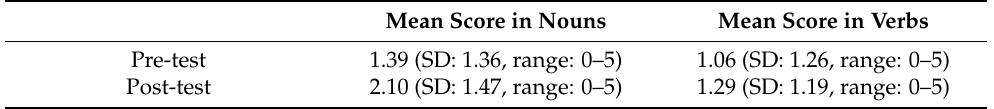
Figure 1. Boxplot graph representing the pupils’ scores in the pre- and post-test of the flashcards intervention. Note: There was one outlier that performed at ceiling in both the pre- and the post- test. Table 6. Pupils’ performance on nouns and verbs for the pre- and post-test of the flashcards intervention.